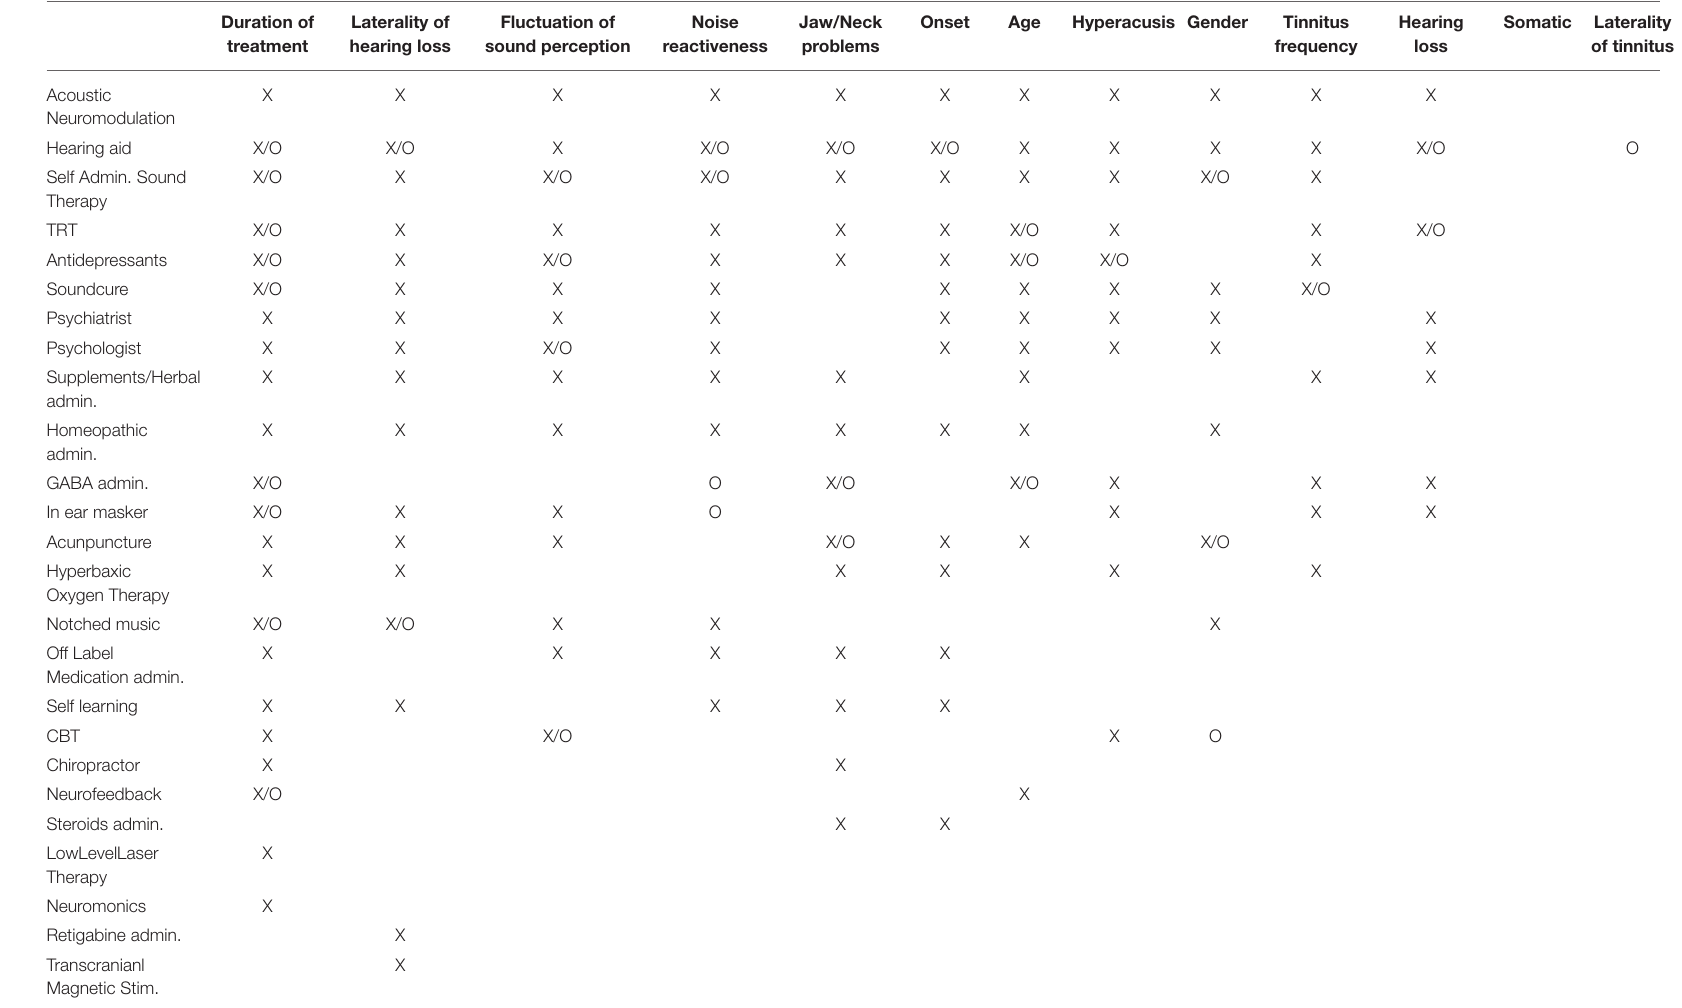
TABLE 3 | Predictors identified as significant by the elastic net model (X) and by linear regressions (O).